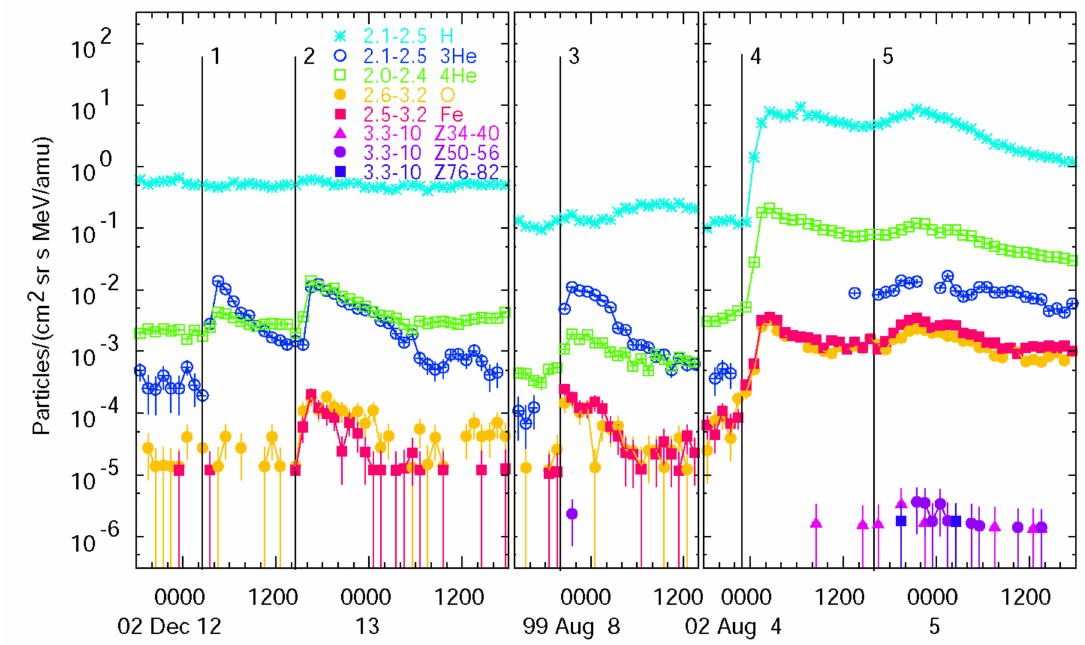
Figure 2. Element intensities at the indicated MeV amu − 1 are shown in a sample of 3 He-rich or “impulsive” SEP events of increasing intensity. 3 He exceeds 4 He in Events 1 and 3. Fe and O are below the background level in Event 1, but Fe/O ≈ 1 in the remaining events. H is below the background level in Events 1–3. 3 He/ 4 He < 0.1 in Event 4 and is not plotted because it falls below the possible resolution error; it is ≈ 0.1 in Event 5 and high- Z heavy elements are beginning to appear [24]. Other properties of the last four of these events are listed